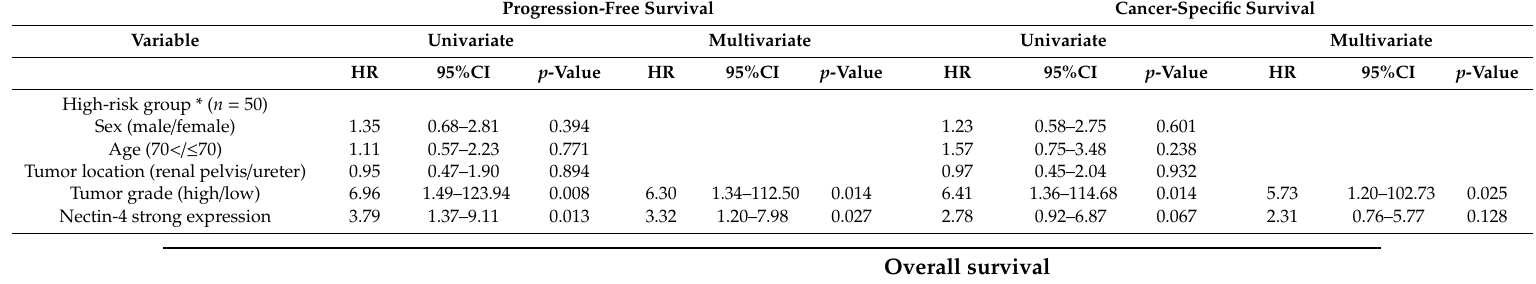
Variable Univariate Multivariate High-risk group * ( n =